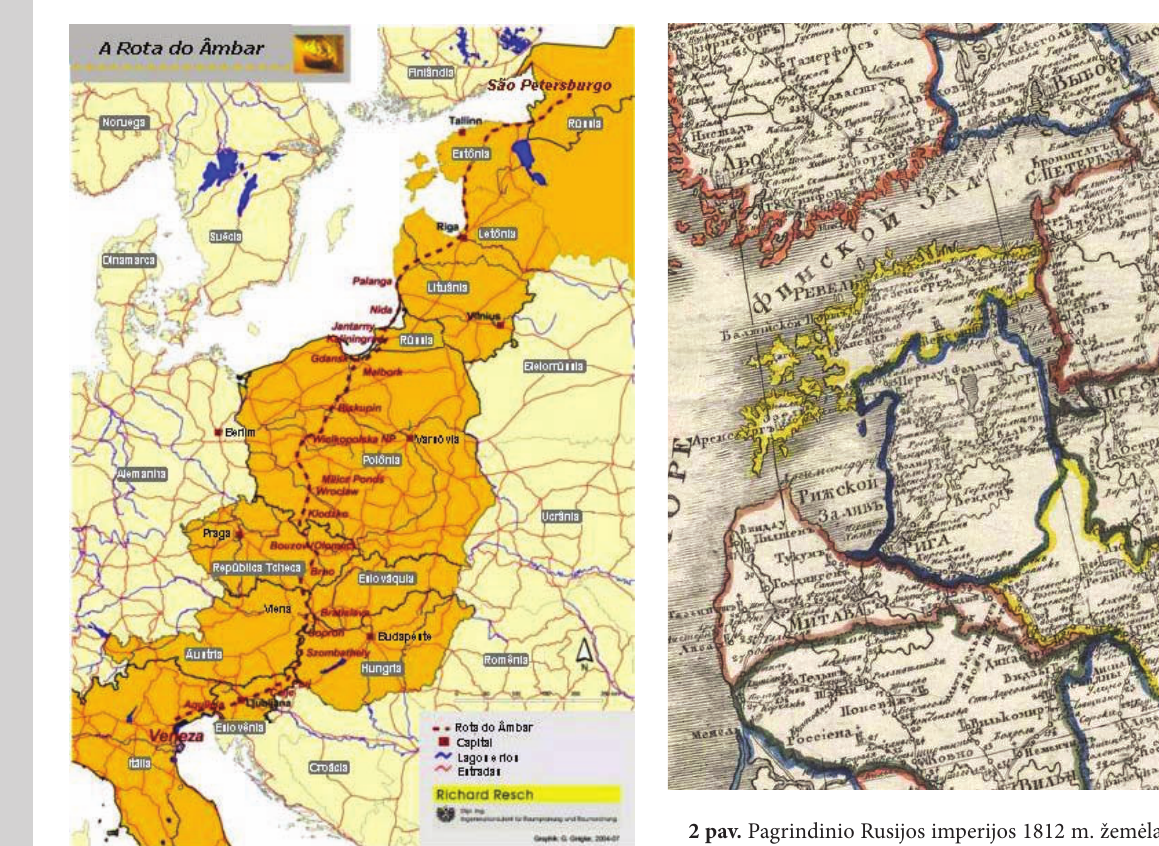
Fig. 1. „Amber road“